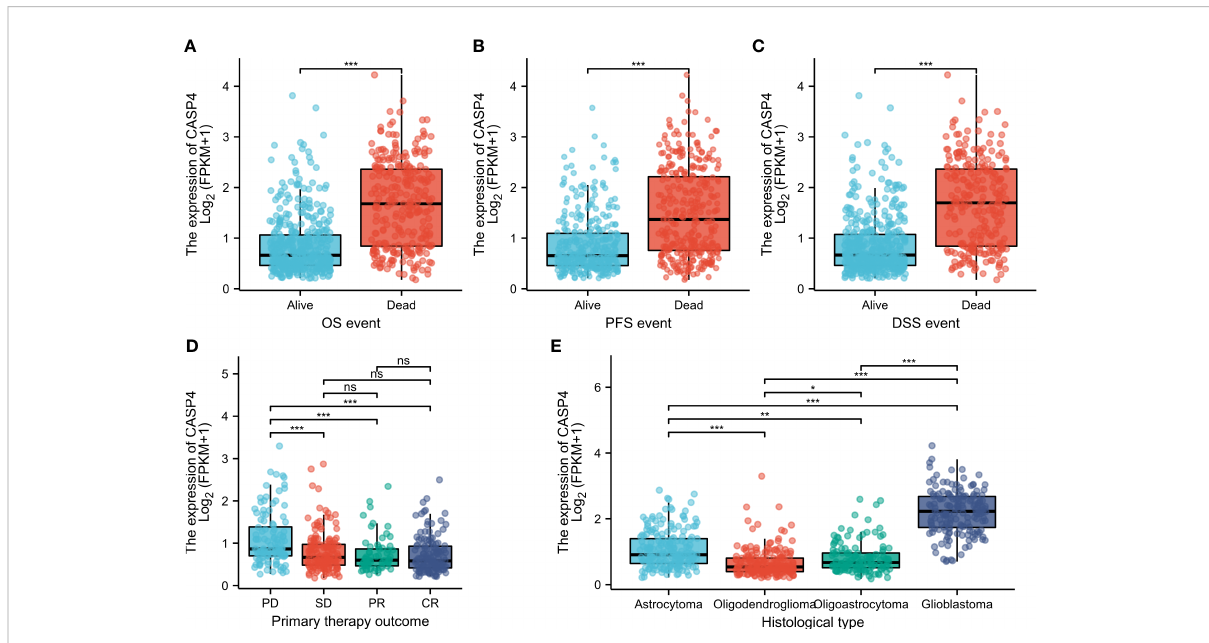
FIGURE 2 Clinicopathological characteristics associated with CASP4 expression in glioma patients in The Cancer Genome Atlas (TCGA) database. (A – C) Association between CASP4 expression and survival. (A) Overall survival. (B) Progression-free survival. (C) Disease-free survival. (D) Correlation between CASP4 expression and primary treatment outcome. (E) Histological type of glioma correlated with CASP4 expression (* P < 0.05; ** P < 0.01; *** P < 0.001; NS, P > 0.05). NS is no signi fi